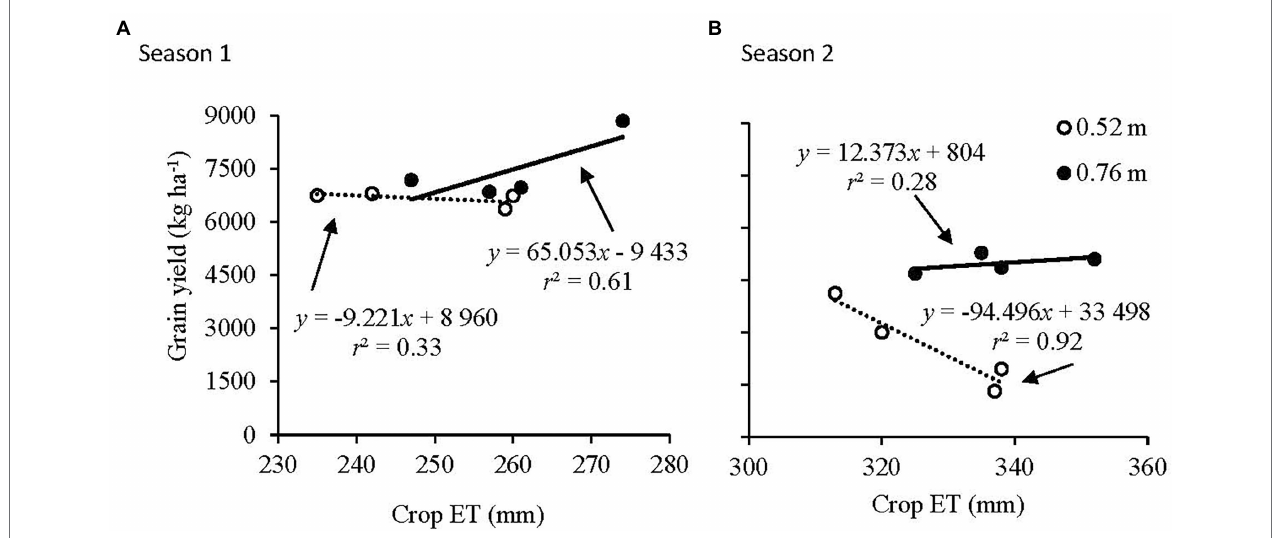
FIGURE 4 | Relationship of grain yield to accumulated crop evapotranspiration (crop ET) at the 0.52 and 0.76 m row spacings in (A) Season 1 and (B) Season